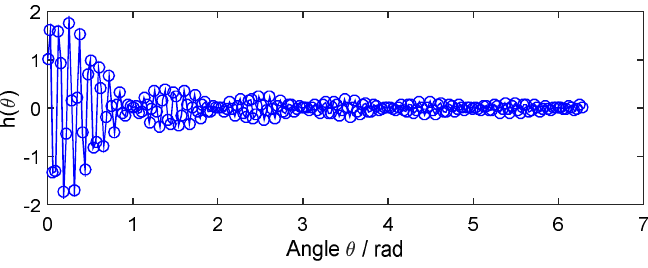
Figure 13. The interpolation function in Equation (22).